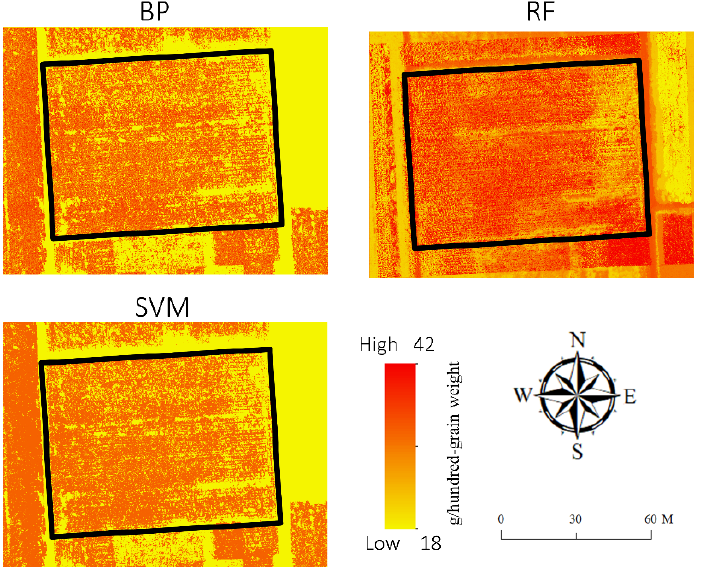
Figure 7. The mapping of maize grain yields using three machine learning methods with optimized parameters.